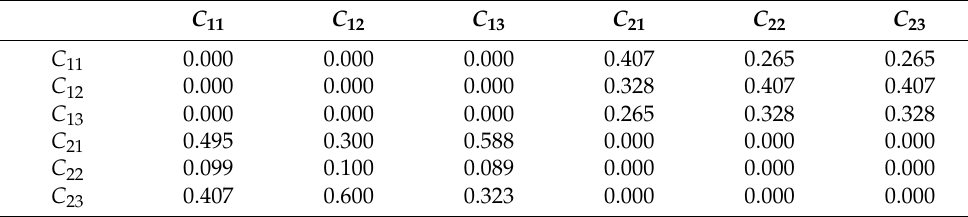
Table 2. Weighted super-matrix.